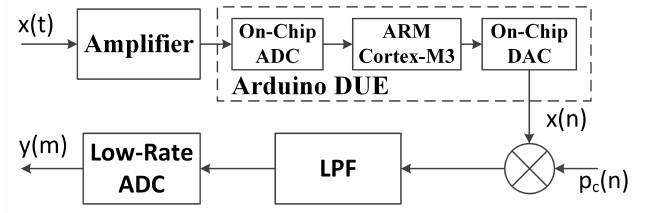
Figure 8. Improved digital AIC